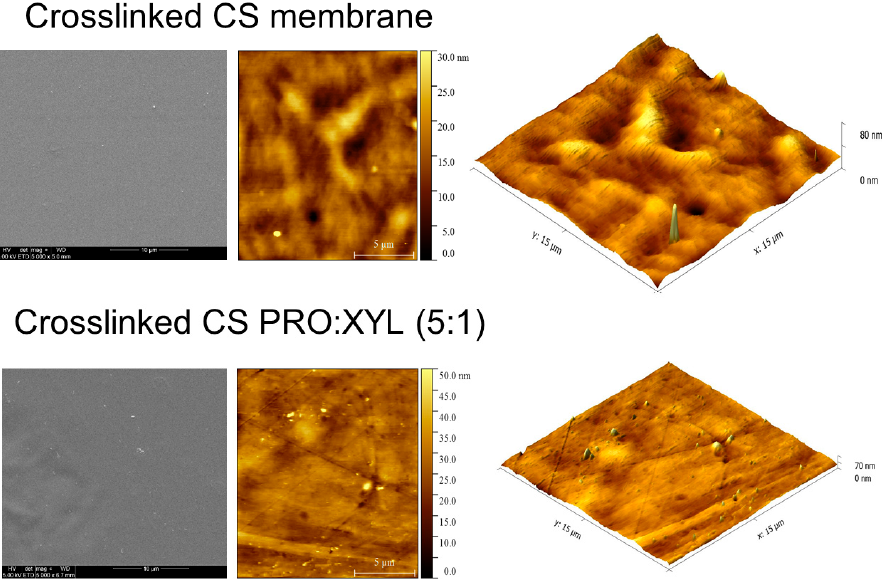
Figure 4. AFM surface and 3D images (15 × 15 µm) of pristine CS and CS:PRO:XYL membranes.